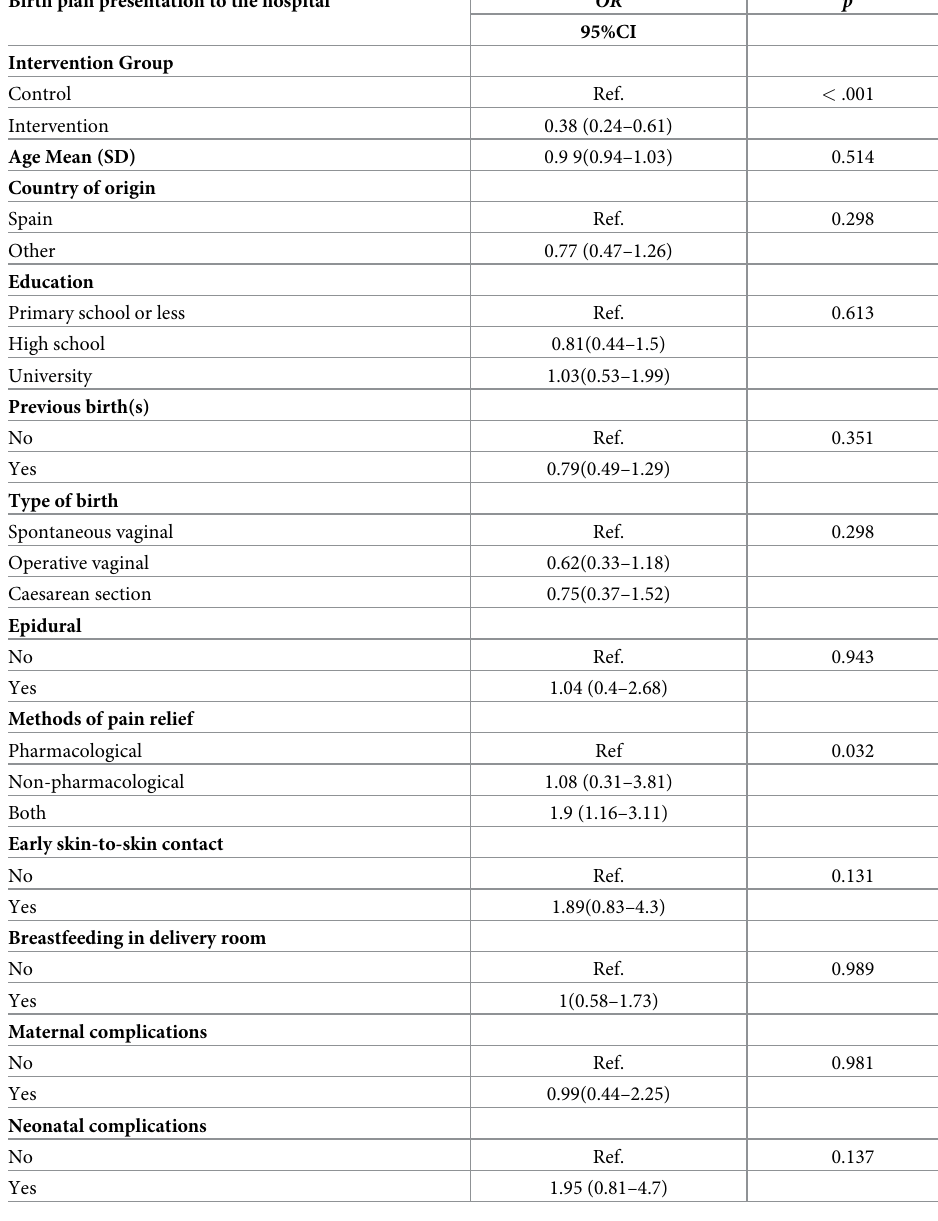
Table 7. Multinominal analysis of the birth plan presentation to the hospital and the intervention groups, demo- graphic and obstetrical variables. Birth plan presentation to the hospital